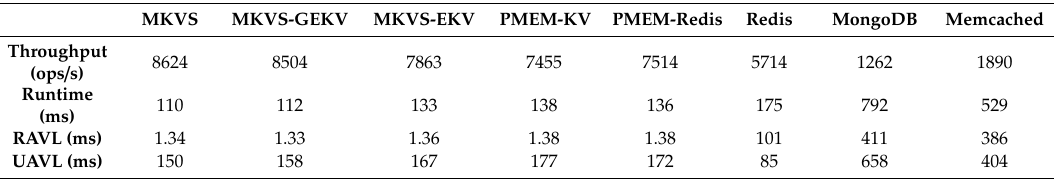
Table 5. The performance in single thread mode with